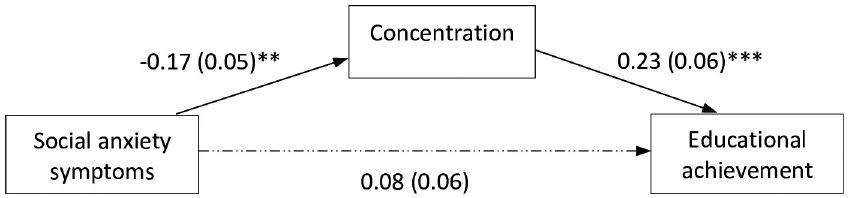
Fig 1. Mediation model testing the direct effect of social anxiety on educational achievement and the indirect effect via concentration (depression symptoms and gender were included as covariates for the dependent variable but are not shown here for ease of interpretation). Values presented are standardized path coefficients, values presented in parentheses are standard errors. �� p < .01; ��� p < .001.